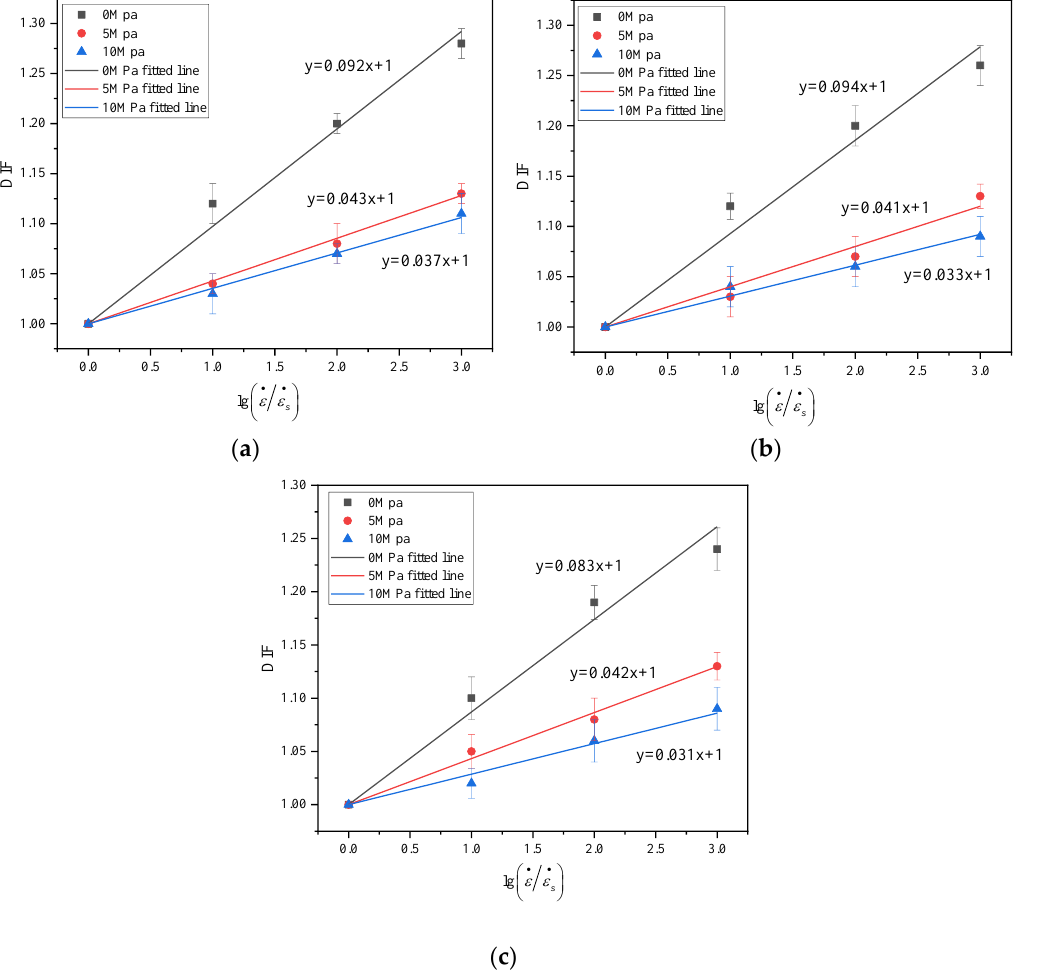
Figure 18. Relationship between DIF and strain rate of concrete subject to 100 F – T cycles under different confining pressure levels. ( a ) SF0, ( b ) SF10 and ( c ) SF20.